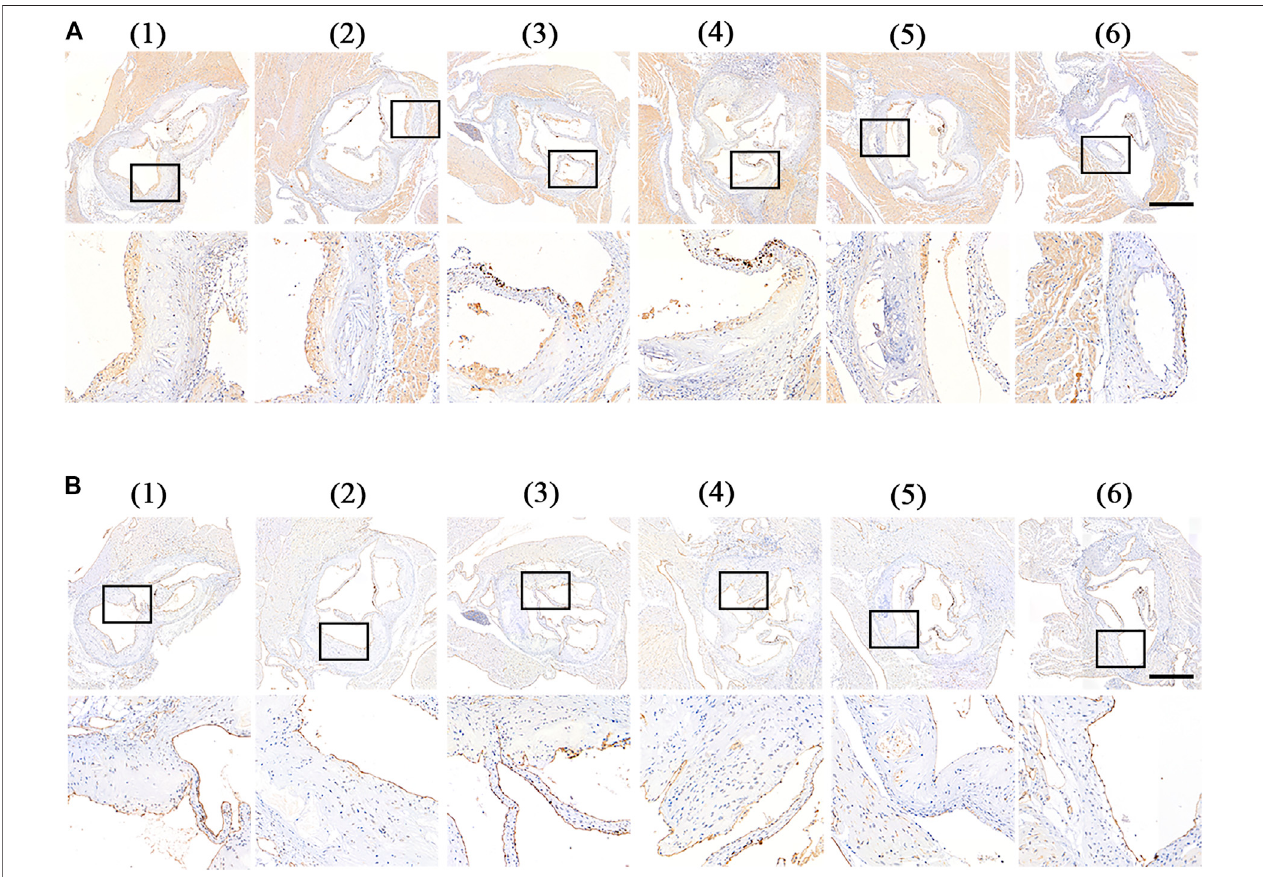
FIGURE8| ImmunohistochemistrystainingofaorticrootsectionsfromApoE − /- miceafterdifferenttreatmentatday30(Wangetal.,2021).-(CostaglioladiPolidoro etal.,2021)referredto(Wangetal.,2021)PBS(Libby,2012),freeRAP(ShapiroandFazio,2016),RAP@NPs(Moriya,2019),RAP@PLTNPs(Winkeletal.,2014),RAP@ NPs + SonoVue ™ + US (Costagliola di Polidoro et al., 2021), RAP@PLT NPs + SonoVue ™ + US. Representative images of immunohistochemistry staining with antibodies to (A) MMP-9 and (B) CD31 (scale bar = 500